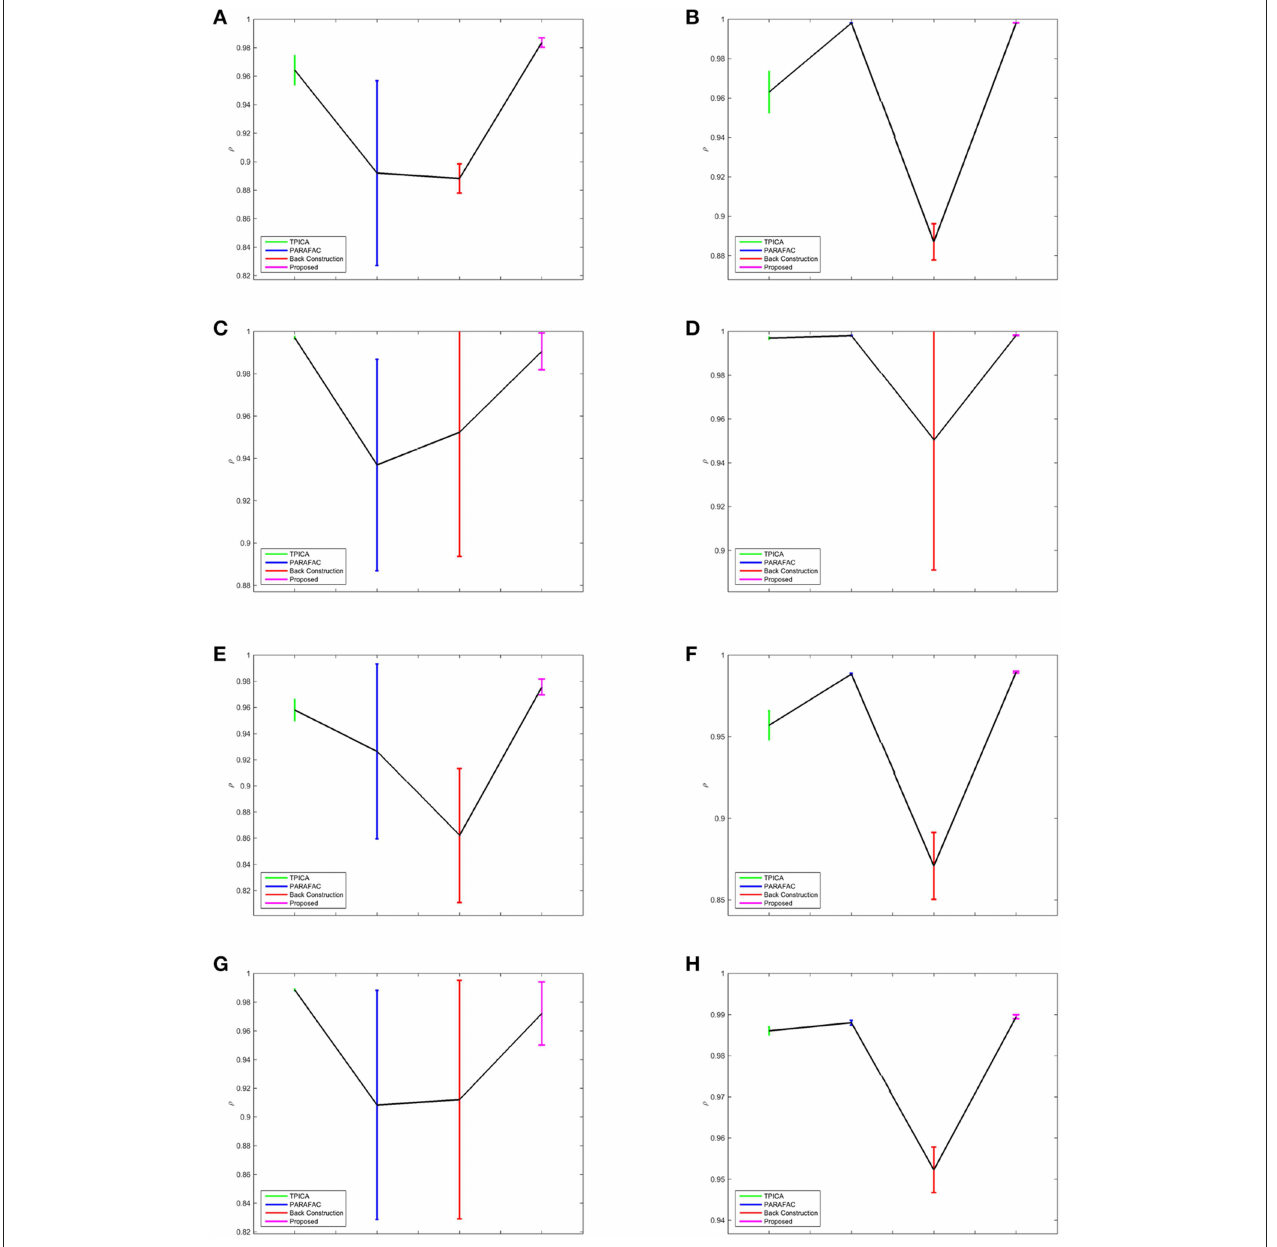
FIGURE 3 | Error Bars of the Experimental Results. The colors of TPICA, PARAFAC, Back Construction Algorithm, proposed Non-Gaussian Penalized PARAFAC from left to right are green, blue, red, and magenta. The vertical axis represents the mean of ρ . The vertical colorful bar represents one std away from the mean value. (A) Experiment A. (B) Experiment B. (C) Experiment C. (D) Experiment D. (E) Experiment E. (F) Experiment F. (G) Experiment G. (H) Experiment H.